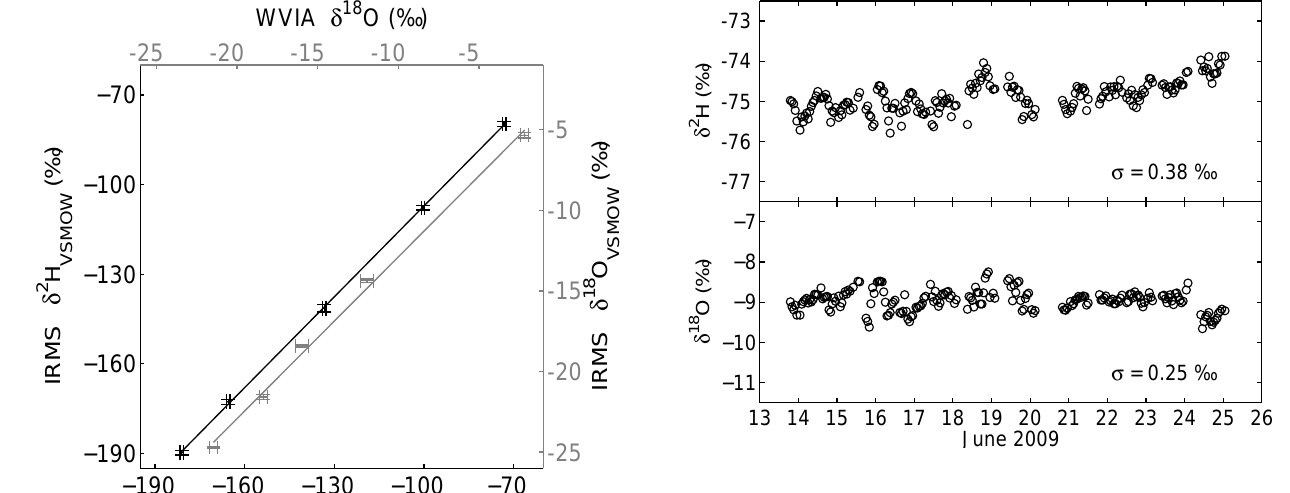
Fig. 10. Repeated analyses of a local water standard with our cali- bration system during 12 days. The standard deviation is 0.38‰ for δ 2 H and 0.25‰ for δ 18 O,